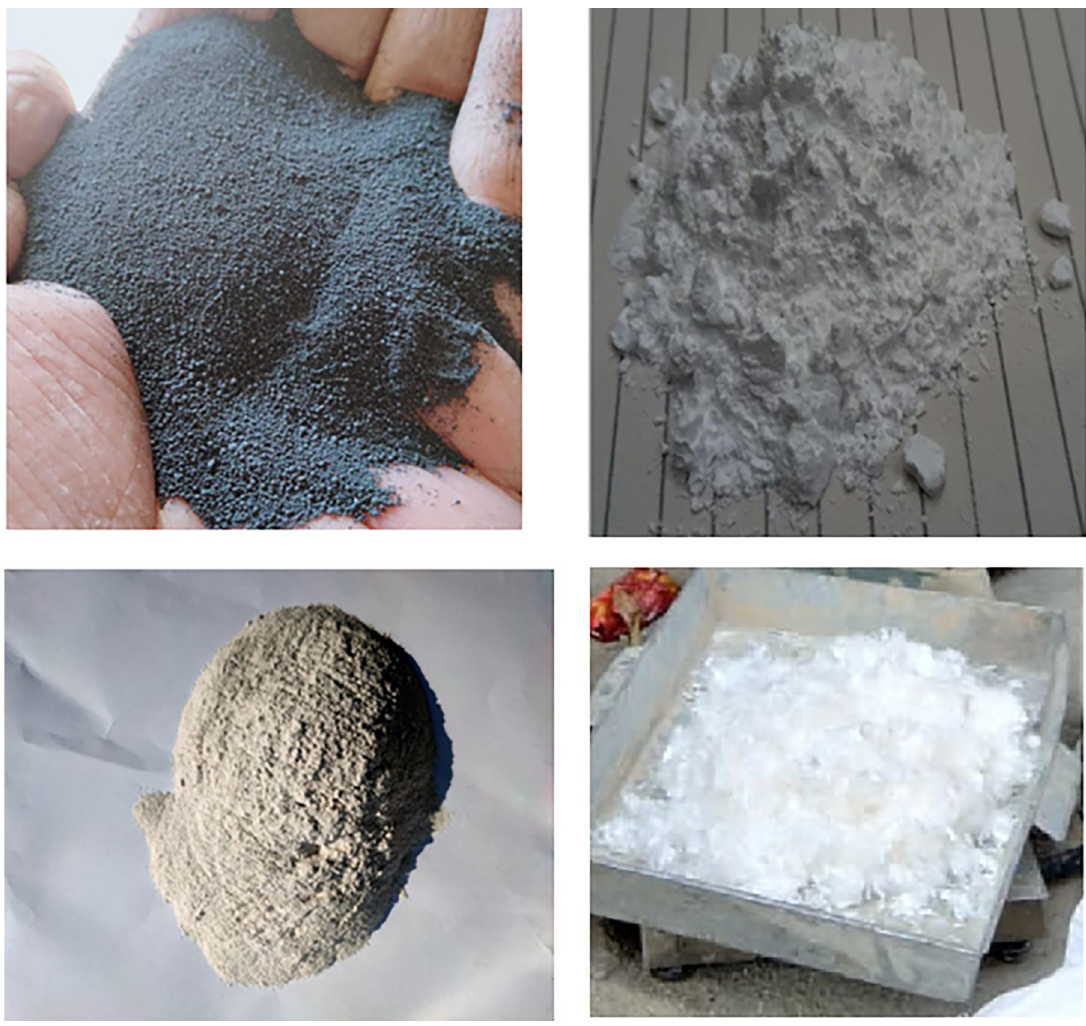
Fig 2. Images of (a) Silica Fume (SF), (b) Nano-Silica (NS), (c) Granulated Blast Furnace Slag (GBFS), and (d) Polypropylene Fibers